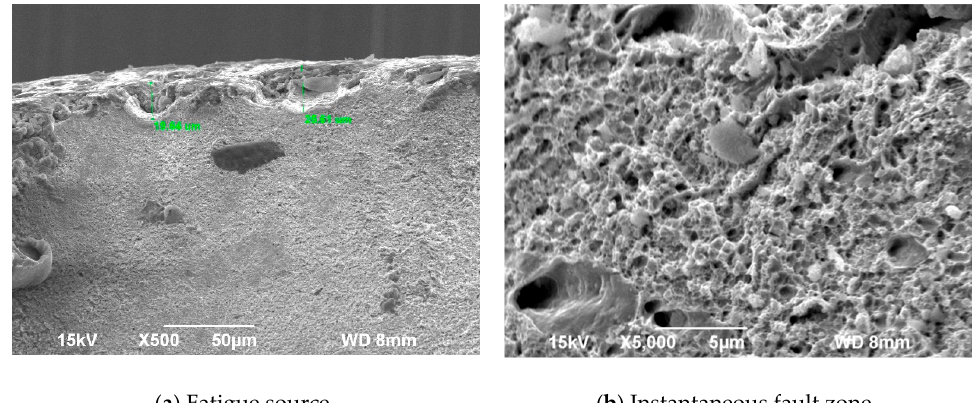
Figure 10. GJX18m fatigue fracture morphology.